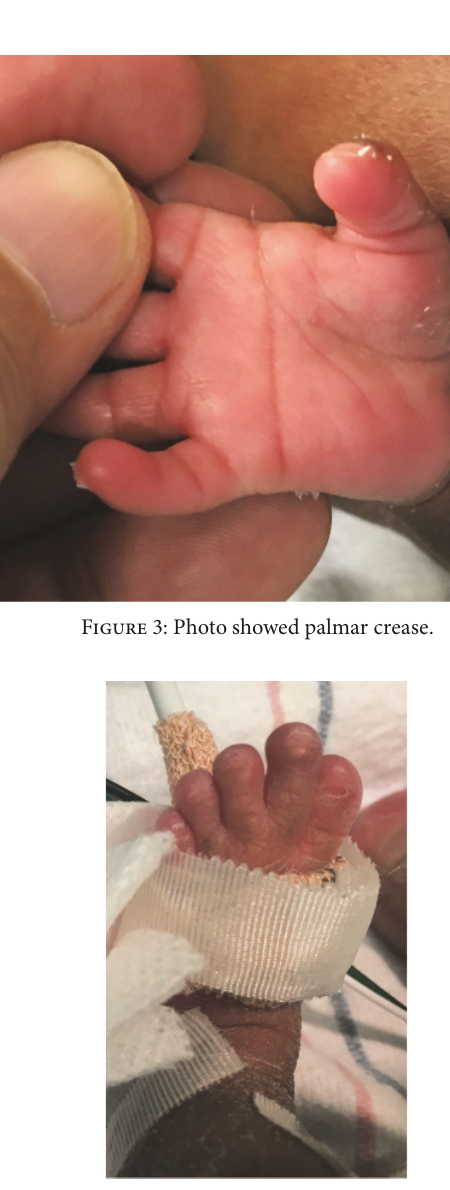
Figure 4: Photo showed overgrowth of the second toe.